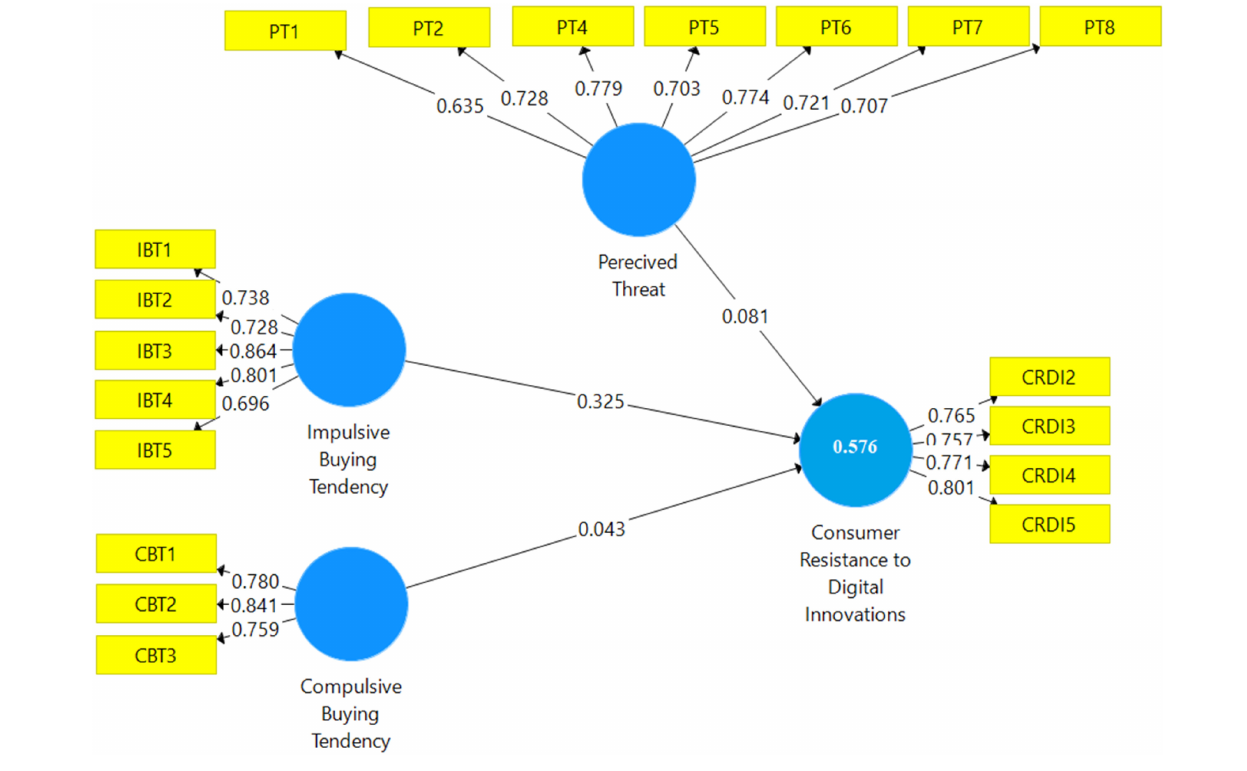
FIGURE 2 | Measurement model.